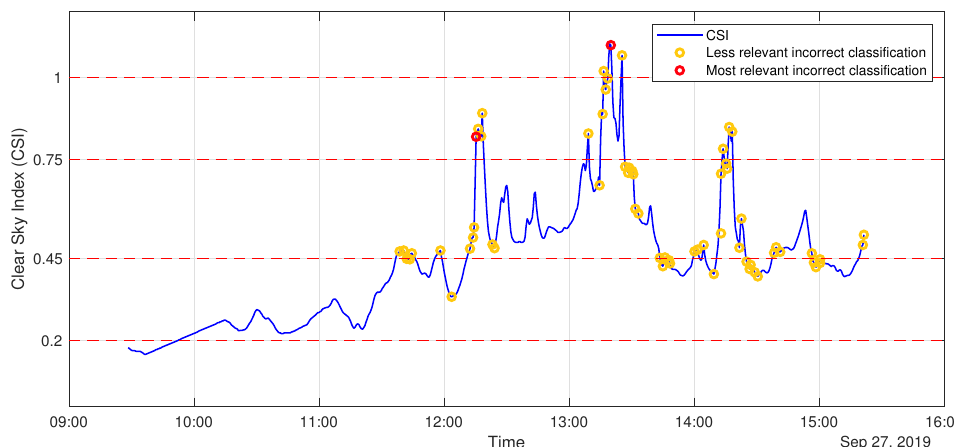
Figure 9. CSI trend with highlighted classification errors for the day of 27 September 2019.